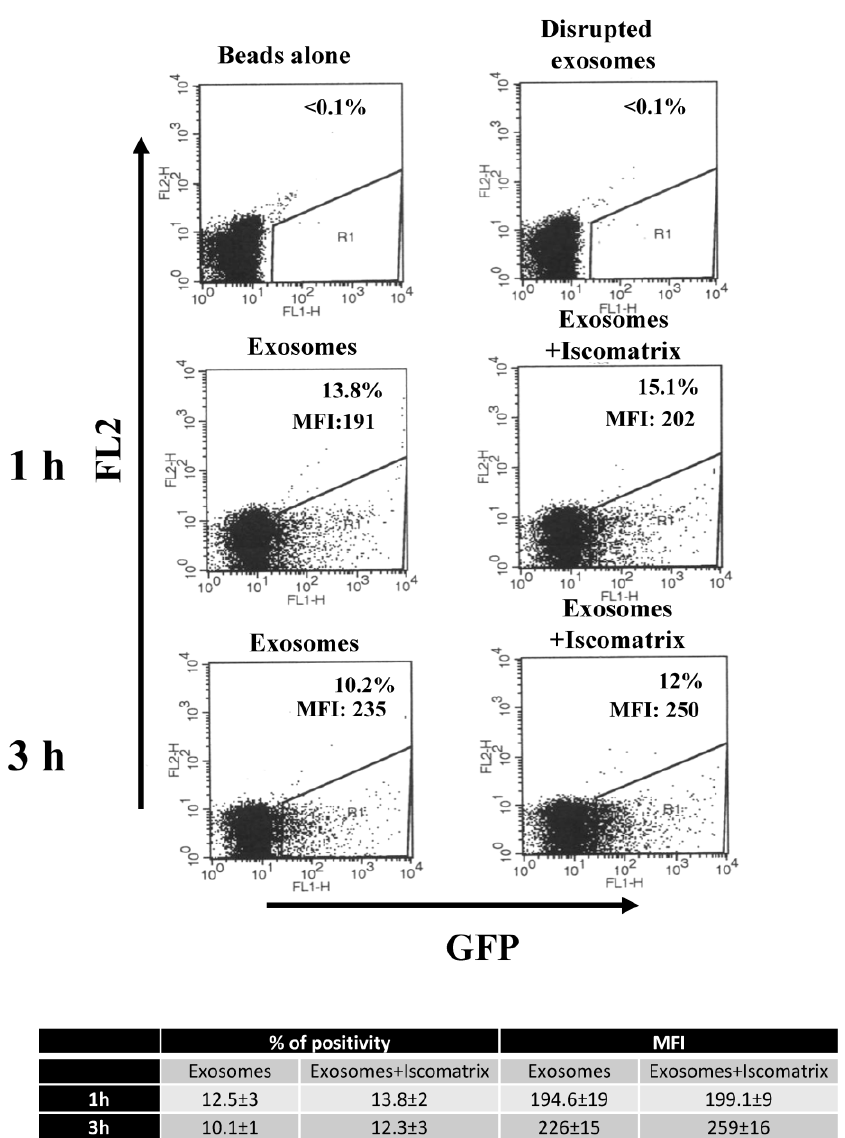
Figure 1. The treatment with ISCOMATRIX TM adjuvant does not affect the exosome-associated fluorescence. Fluorescent exosomes were incubated in the absence or presence of 23 ISCO TM U/mL of the adjuvant at 37 ◦ C with aldehyde sulphate beads in a rotating plate. After 1 and 3 h, samples were washed, and analyzed by FACS. As a control, equivalent amounts of fluorescent exosomes were heated at 95 ◦ C for 10 min before incubation with beads. Results representative of three independent experiments with duplicates are shown. In each plot, both percentages and, where relevant, mean fluorescence intensity (MFI) of fluorescent beads are indicated. At the bottom, mean values ± SD of both percentages and MFI of fluorescent beads from the three experiments are reported. Iscomatrix: ISCOMATRIX TM